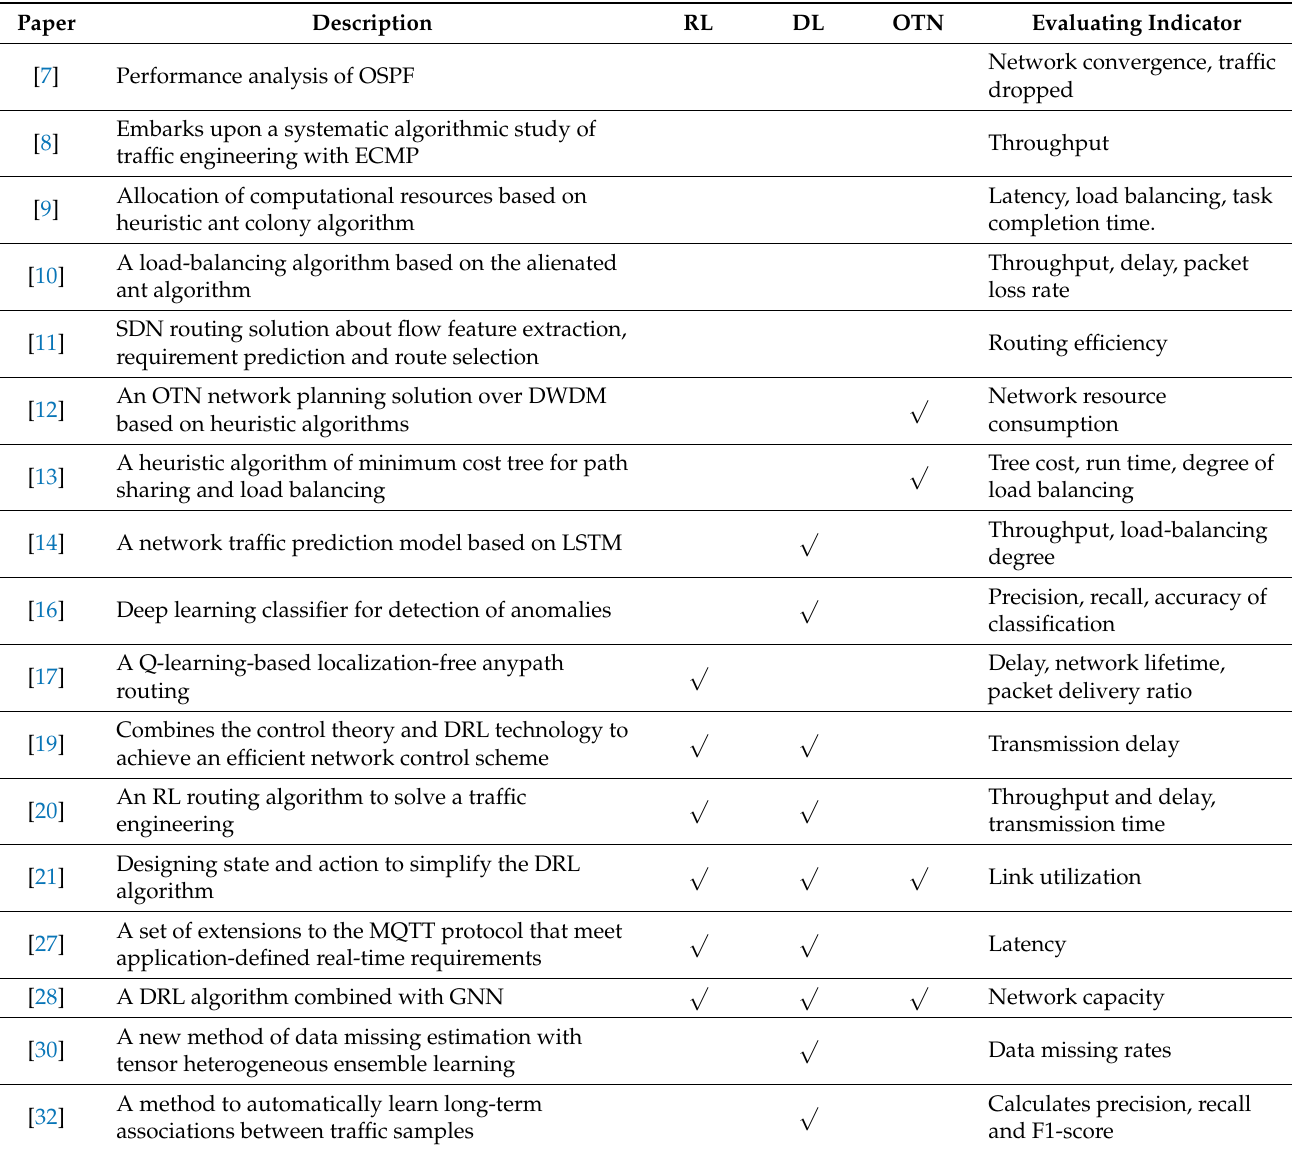
Table 1. Related